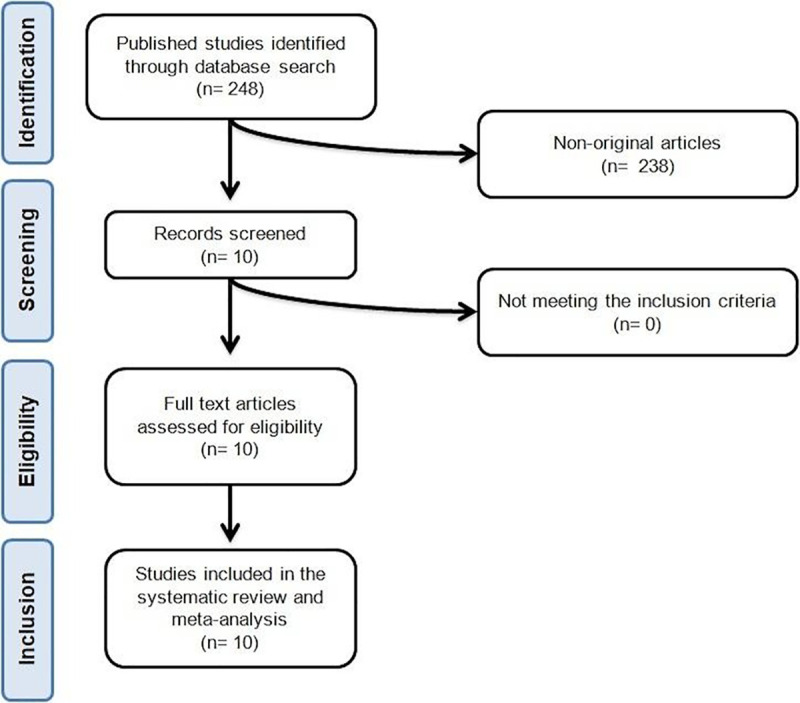
Flow chart of the number of studies identified and included in the meta-analysis.Data were pooled from 10 trials comprising 26 treatment arms, which included overall 3,788 individuals, with 2,460 in the active arm and 1,328 in the control arm.